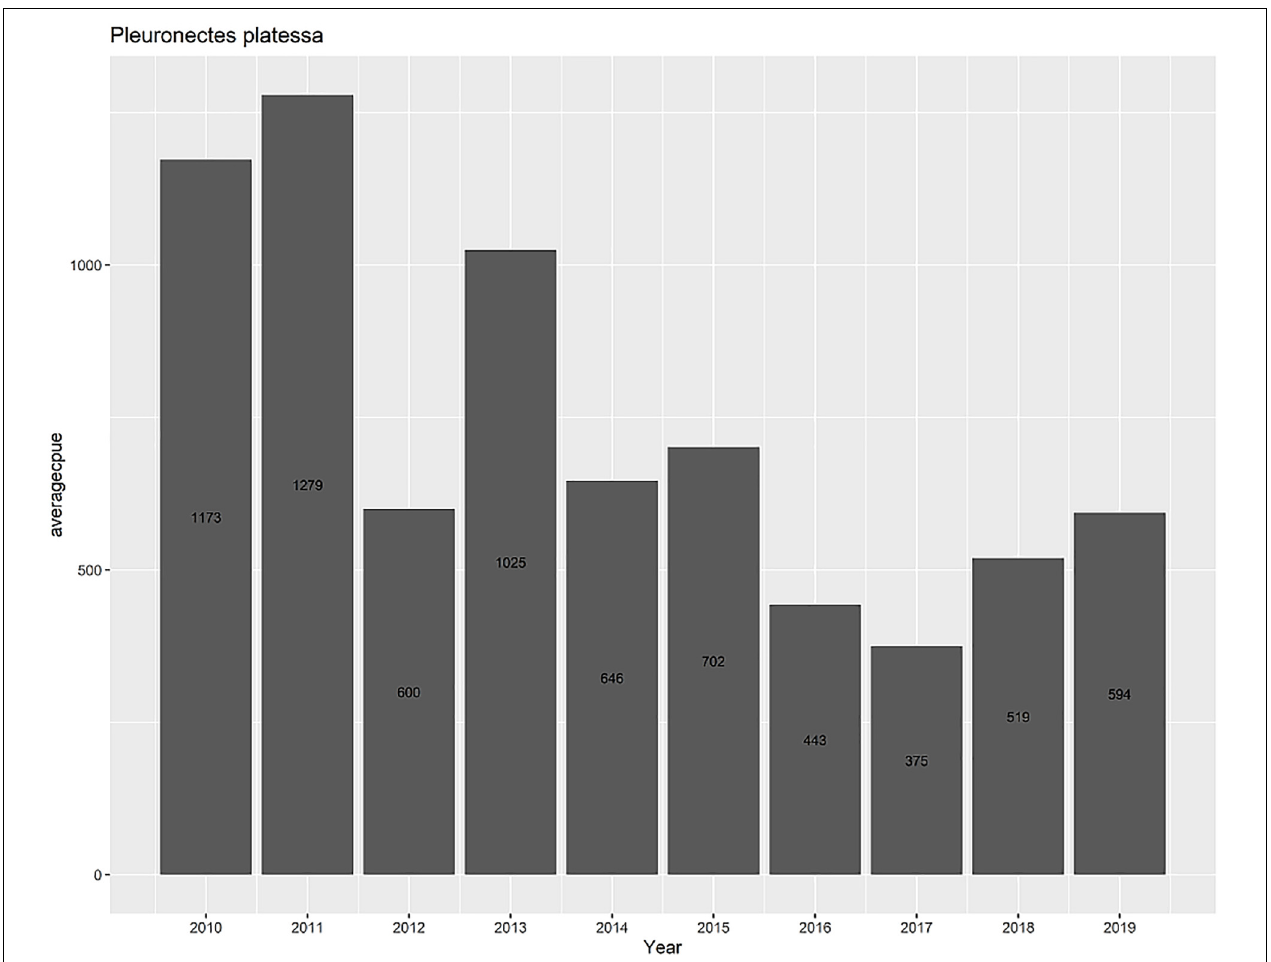
FIGURE 3 | Average beam trawl survey catches (numbers/km 2 ) for plaice ( Pleuronectes platessa ) in the southern North Sea (ICES area IVc) for the period 2010–2019. CPUE, catch per unit effort.